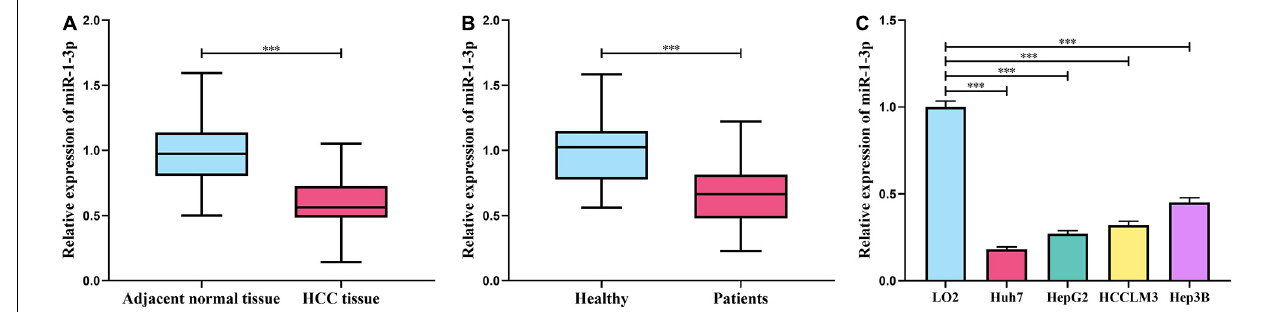
FIGURE 1 | MiR-1-3p was downregulated in HCC. (A) Expression of miR-1-3p in HCC tissues and adjacent tissues was detected using qRT-PCR. (B) Expression of miR-1-3p in the serum of HCC patients and healthy controls was detected using qRT-PCR. (C) Expression of miR-1-3p in HCC cell lines and normal liver cells was examined by qRT-PCR. *** represents p < 0.001,